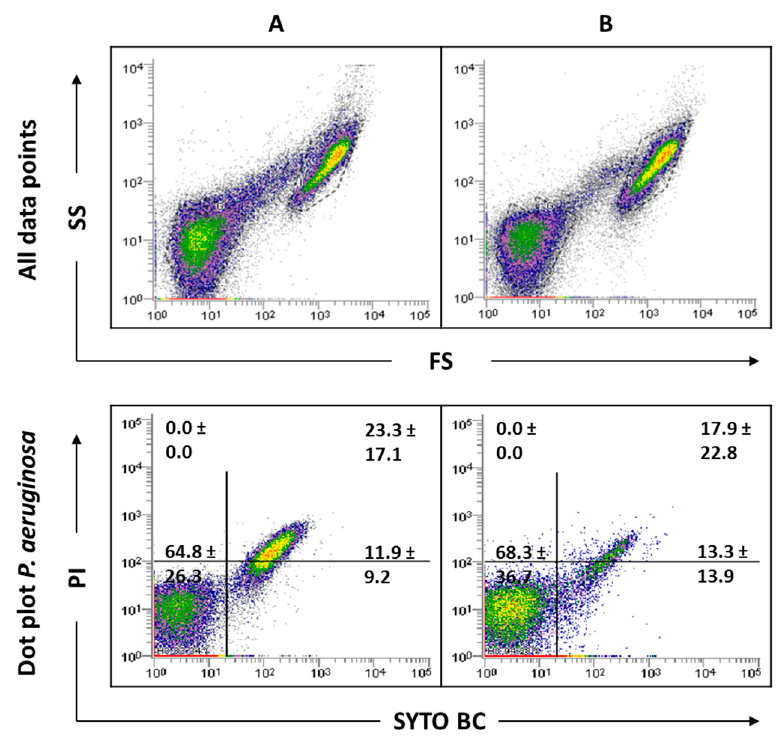
Figure 4. Representative dot plots obtained by FCM for C. albicans 324LA / 94 biofilms before ( A ) and after ( B ) extraction of biofilm matrix.